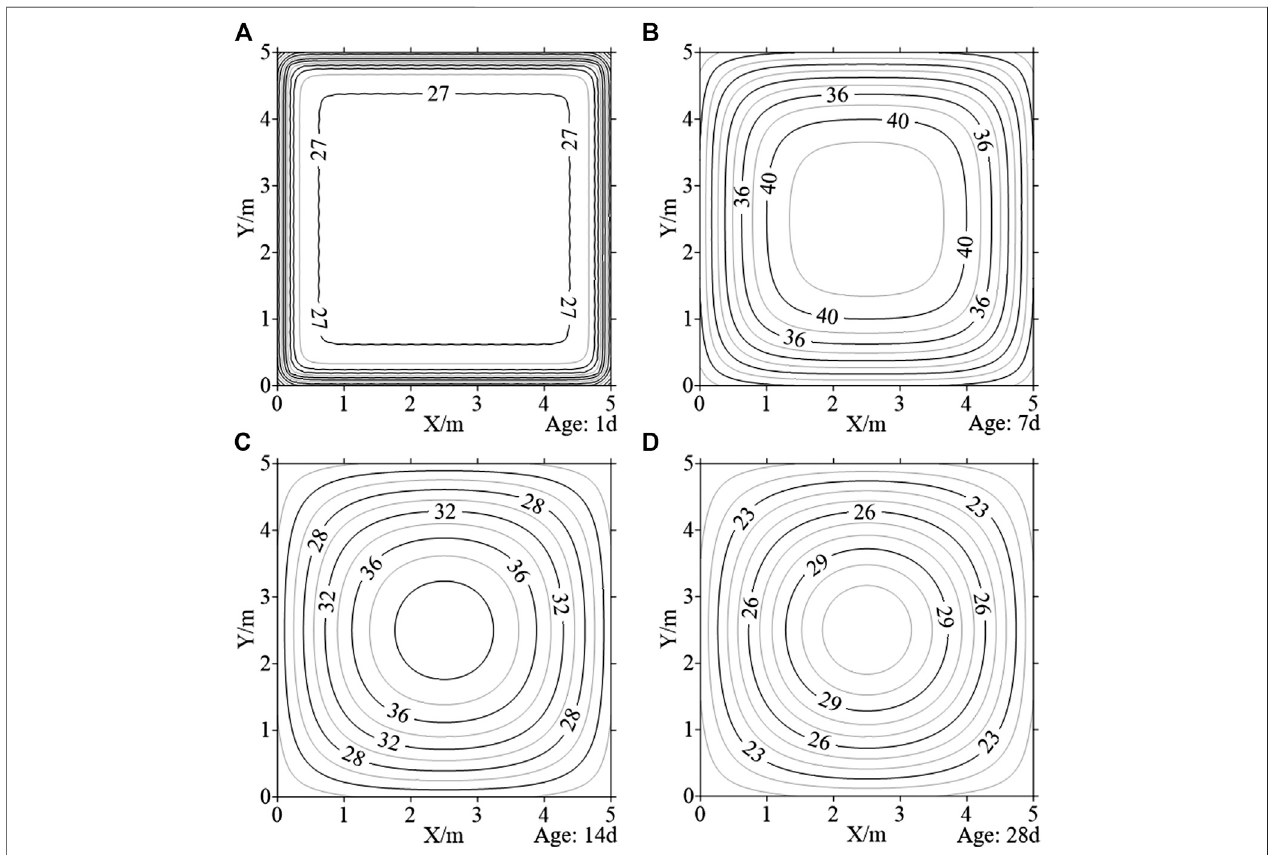
FIGURE 3 | The simulated thermal fi eld of the concrete block: (A) 1 day; (B) 7 days; (C) 14 days; (D) 28 days.